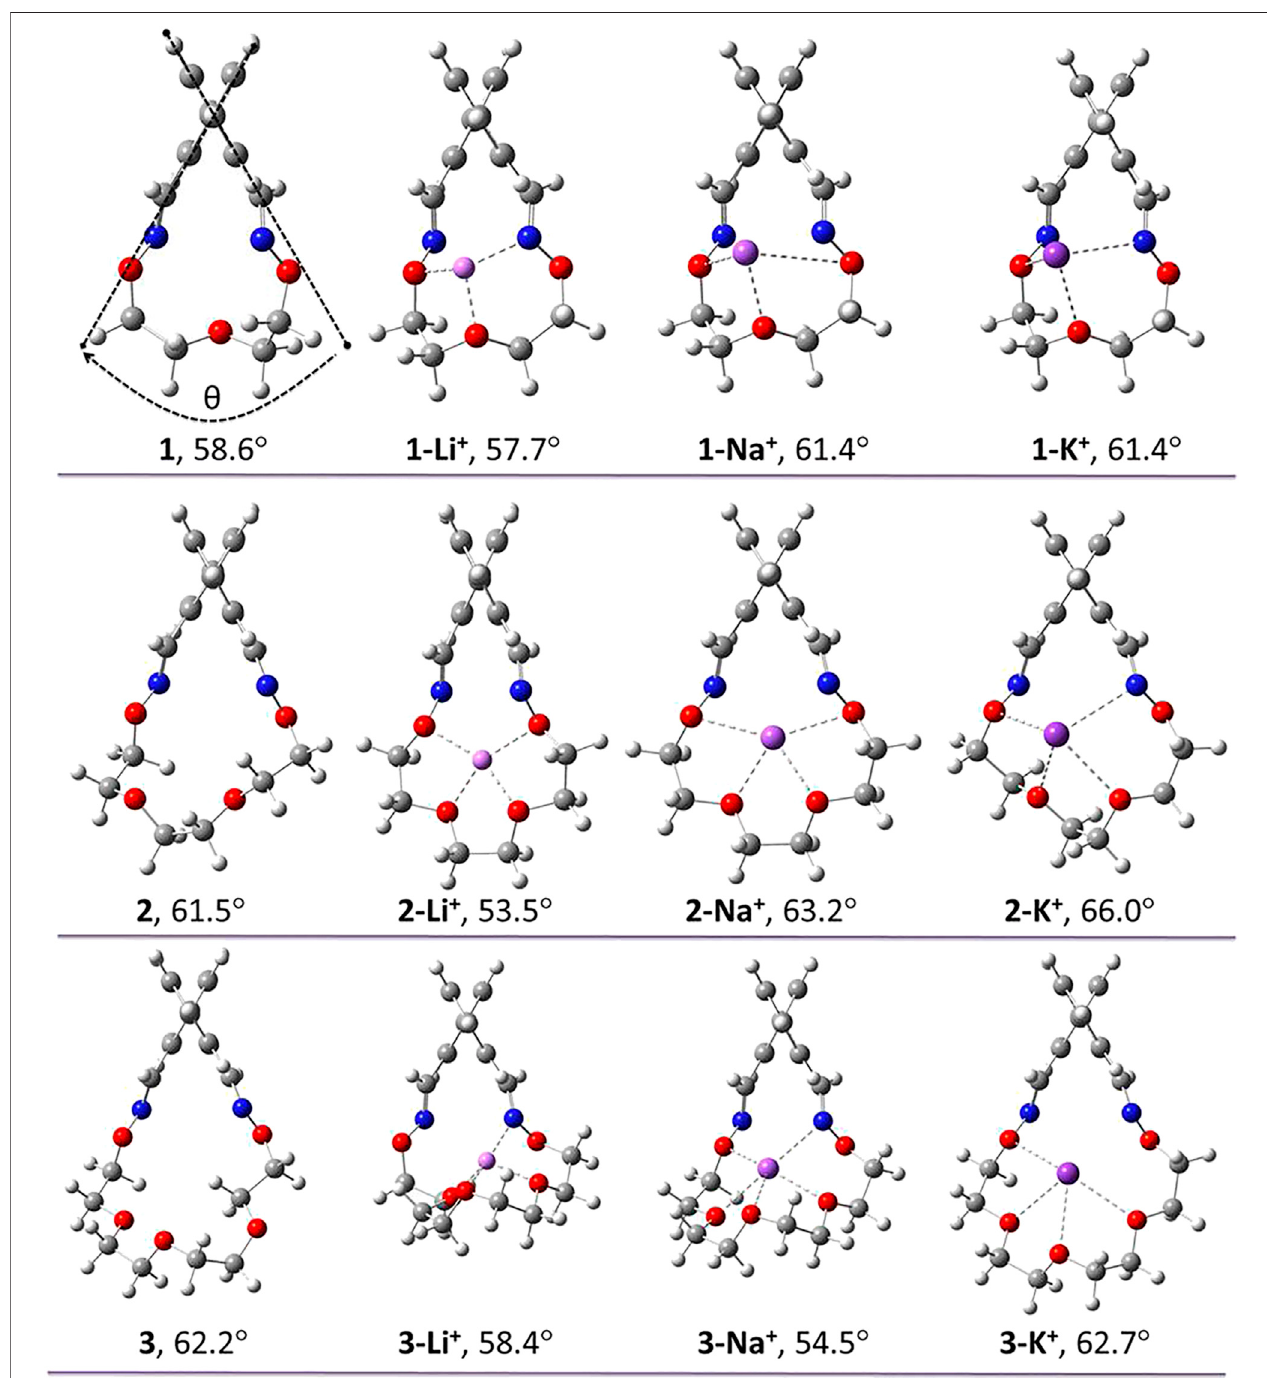
FIGURE 1 | Side view and torsion angle for the computed molecular structures of macrocycles 1 – 3 and their alkali metal ion (Li + , Na + , K + ) complexes. The arrow indicates the sense of the helix.